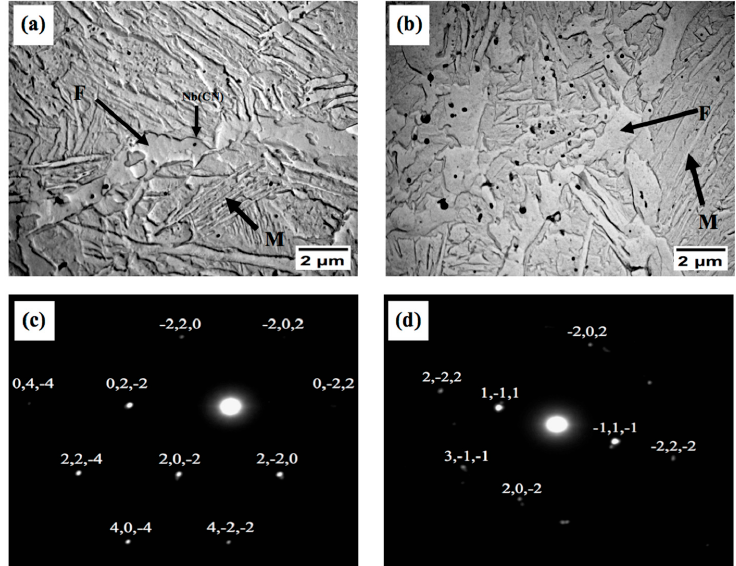
Figure 5. ( a ) TEM micrographs from carbon extraction replicas showing dark precipitates NbCN within ferrite and martensite obtained upon schedules with the FRT = 850 °C and ( b ) FRT = 700 °C; ( c , d ) SADPs of particles indicated by arrows in micrographs above; ( c ) FRT = 850 °C, ( d ) FRT = 700 °C.